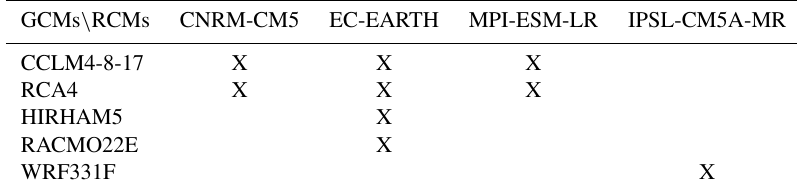
Table 1. RCMs and GCMs considered.